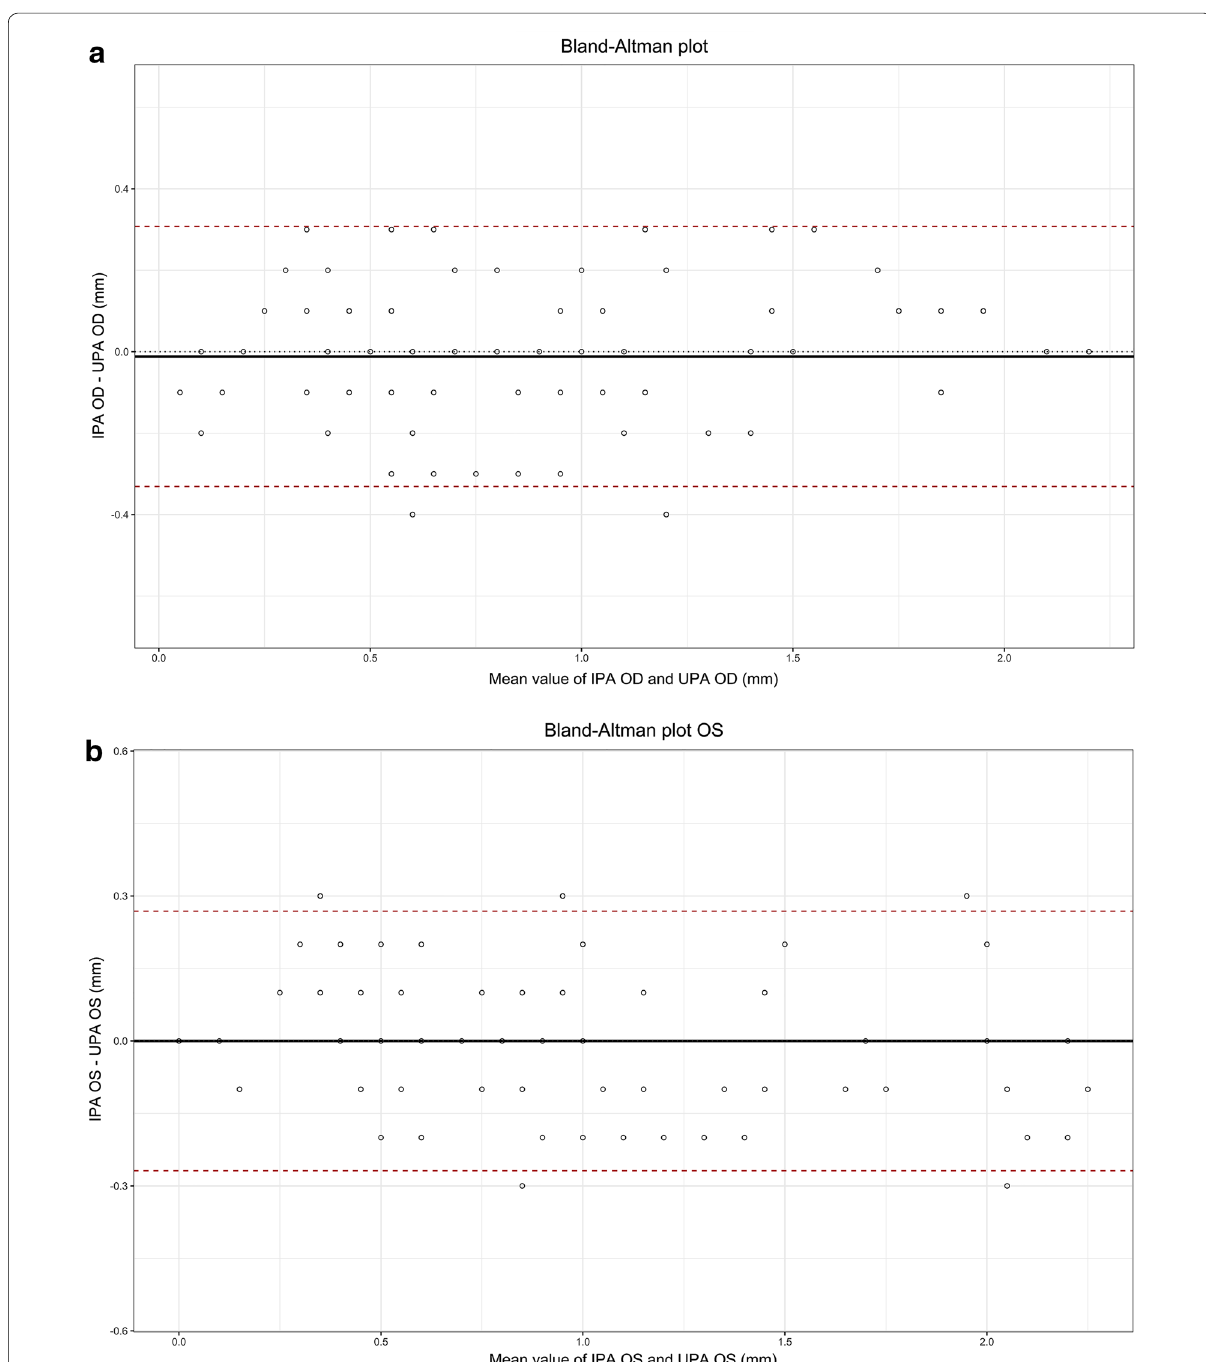
Fig. 5 Bland–Altman graphs show the agreement between the IPA and UPA. Panels a and b demonstrate the agreement between UPA and IPA for OD and OS, respectively. Panels c and d demonstrate the agreement between UPA and IPA for OD and OS, respectively, in neurocritically ill patients. The solid lines represent the average of the differences; dashed lines indicate limits of agreement (mean